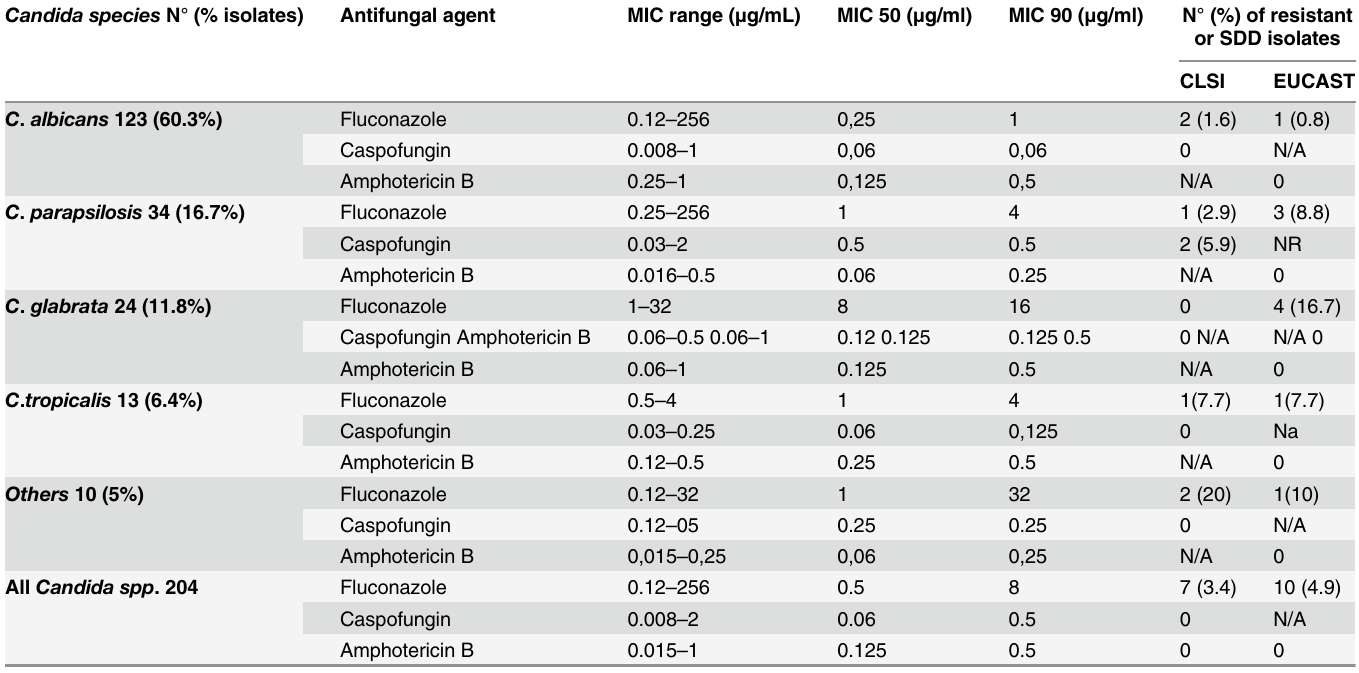
Table 2. MIC 50 , MIC 90 , and susceptibility of Candida strains to antifungals. Candida species N° (%